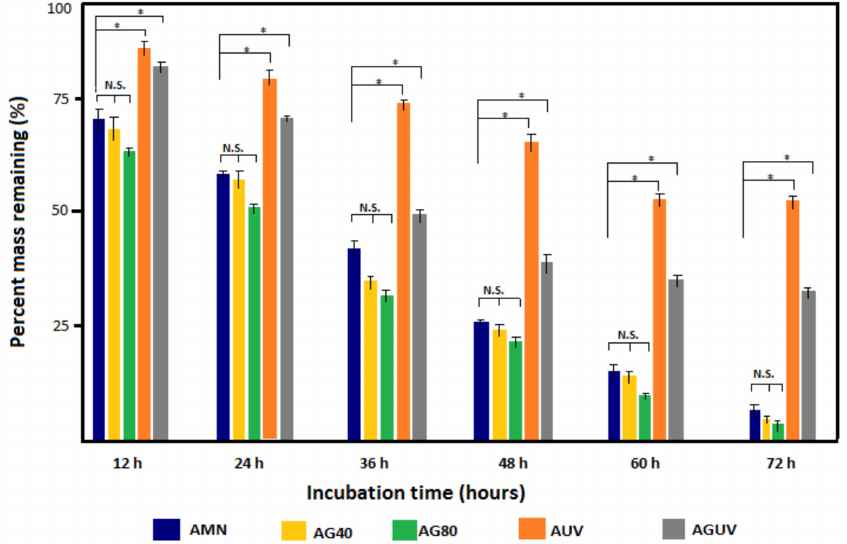
Figure 8. Collagenase digestion of the amniotic membrane after different treatments: natural mem- brane (AMN), gentamicin treatment with 40 mg/mL (AG40), gentamicin treatment with 80 mg/mL (AG80), 1 h exposure to UV (AUV) and 1 h exposure to UV after gentamicin treatment (AGUV). * p < 0.05 was considered significant;